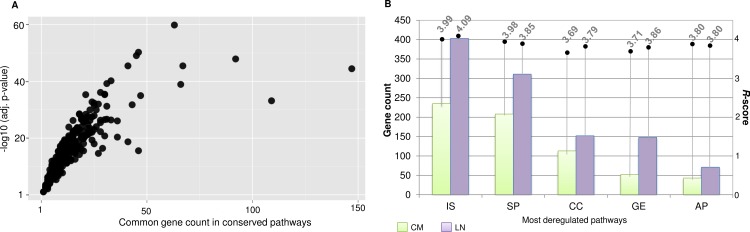
A. Scatter plot representing the statistical significance of gene composition similarity in pathways conserved in both melanoma stage. Log transformed fishers exact p-value is plotted against the common number of genes of a pathway commonly enriched within two different metastatic melanoma stages. B. Bar graph representing the gene count enriched for top 5 (on the basis of R-score represented on the right axis) conserved within metastatic stages. Here, IS is “Immune System”; SP is “Signalling Pathway”; CC is “Cell Cycle”; GE is “Gene Expression”; AP is “Apoptosis”.